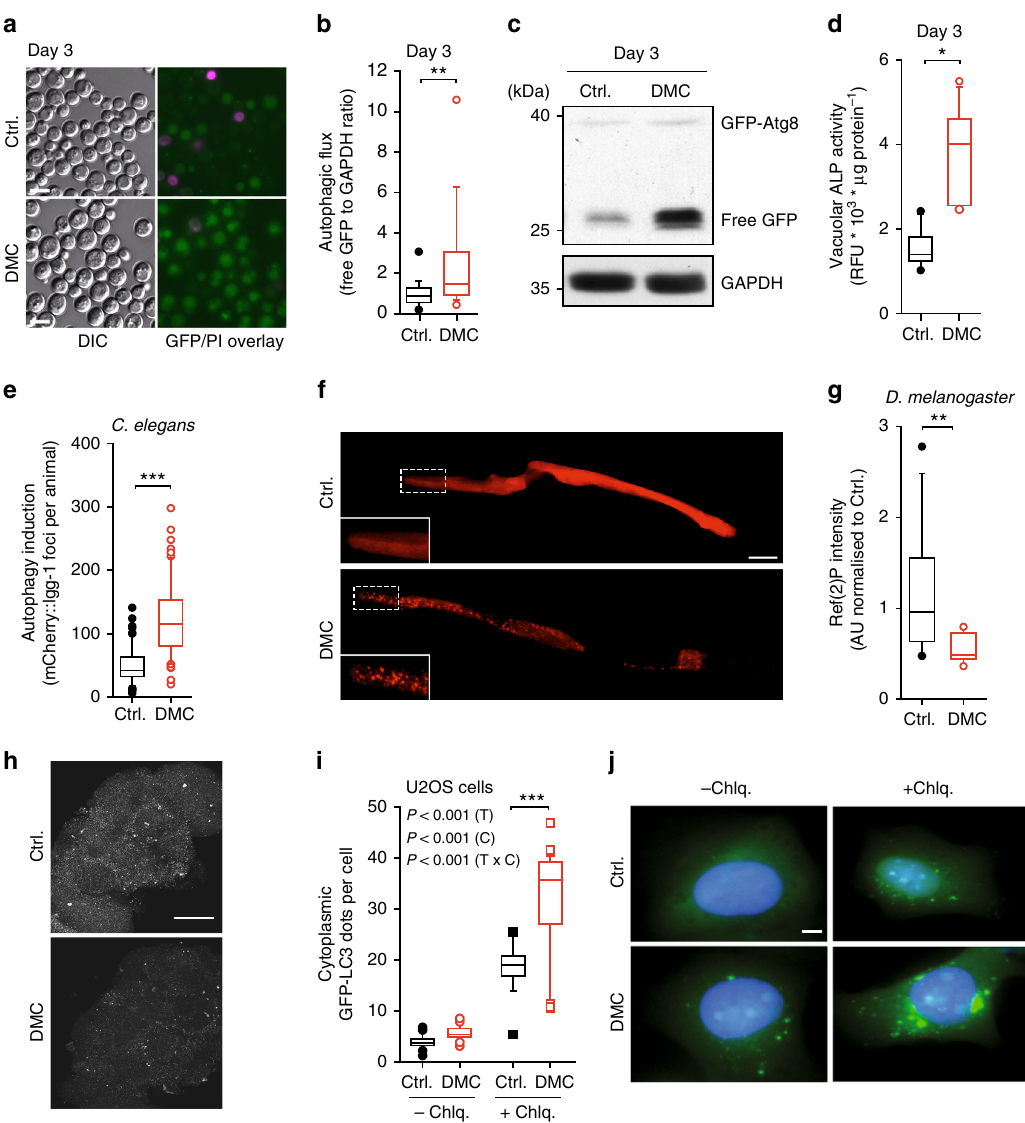
Fig. 2 4,4 ′ -dimethoxychalcone induces autophagy across species. a – d Autophagic fl ux in DMC-treated (100 µ M) yeast indicated by the vacuolar accumulation of GFP-Atg8 (green); a representative micrograph is shown in ( a ), where propidium iodide (PI) counterstaining served to visualise dead cells (magenta). Corresponding quanti fi cation was performed by analysing the free GFP/GAPDH ratio ( b ). ** P = 0.0024, n = 19 (Ctrl.), 18 (DMC) independent biological replicates; c representative immunoblot. Autophagy measured via alkaline phosphatase (ALP) activity of Pho8 Δ N60 strains ( d ). * P = 0.0020, n = 11 independent biological replicates. See Supplementary Figure 5d for other time points. e , f Quanti fi cation ( e ) and representative pictures ( f ) of mCherry-foci in the intestine cells of DMC-fed (41.6 µ M) young adult worms expressing Pnhx-2::mCherry::lgg-1. *** P < 0.0001, n = 61 (Ctrl.), 65 (DMC) animals. Scale bar: 50 µ m. g , h Immuno fl uorescence analysis ( g ) and representative pictures ( h ) of ref. 2 P-marked protein aggregates in fl y brains after 30 days DMC feeding (200 µ M). ** P = 0.0026, n = 12 (Ctrl.), 11 (DMC) animals. Scale bar: 50 μ m. Signi fi cance in ( b , e , g ) was assessed by two-sided Student ’ s t -tests, in ( d ) by ANOVA/Bonferroni. i , j Videomicroscopic analysis ( i ) and representative pictures ( j ) of DMC-treated (50 µ M) U2OS cells expressing GFP-LC3 with or without chloroquine, cell nuclei were stained with Hoechst 33342. Comparisons by two-way ANOVA (T, treatment; C, 30 (DMC + Chlq) independent biological replicates. Scale bar: 10 μ m. Box plots represent IQR (line at median) and whiskers 10 – 90 percentile. Source